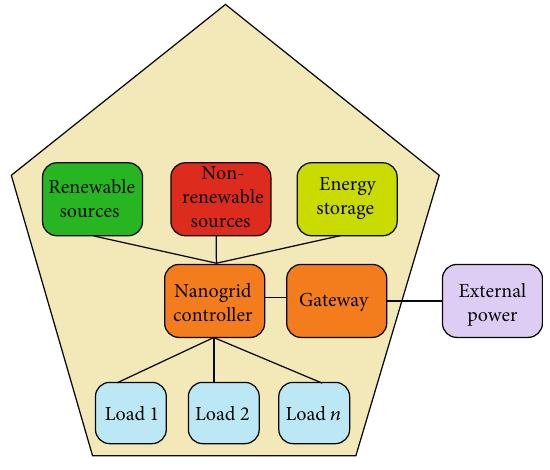
Figure 8: Nanogrid block